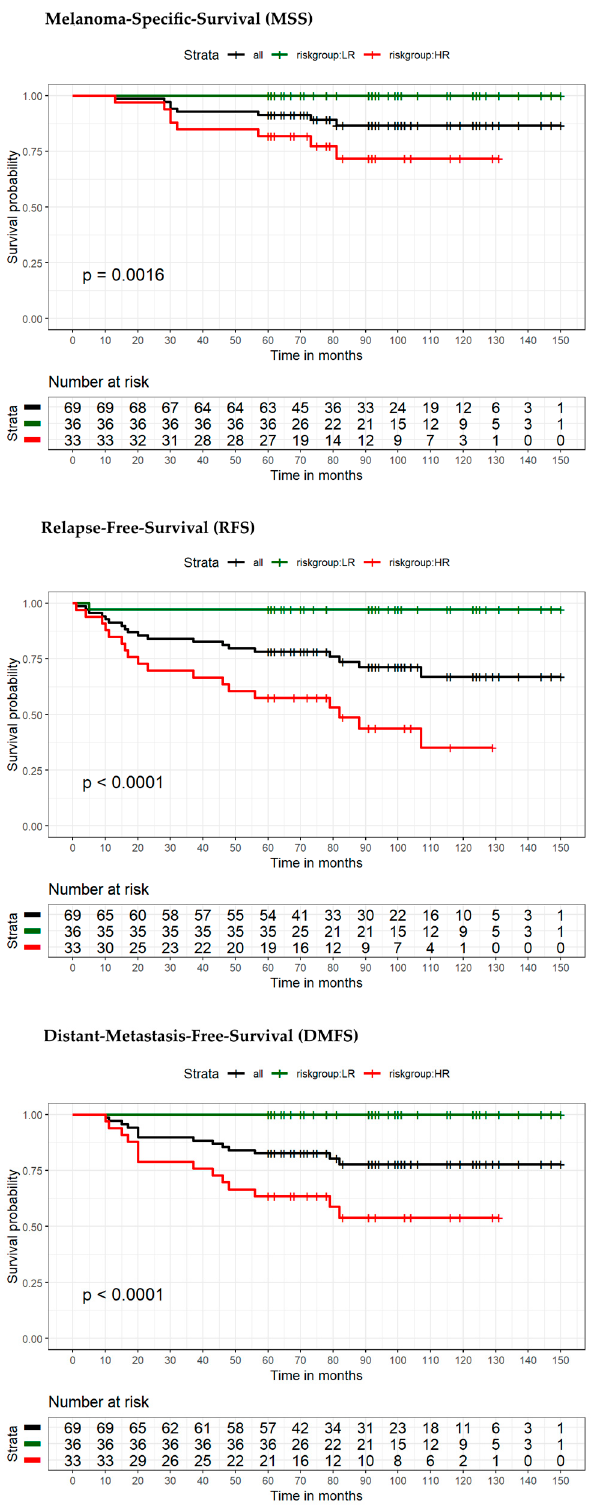
Figure 7. Kaplan–Meier survival estimates of patients with positive nodal status stratified into high- Figure 6. Kaplan–Meier survival estimates of patients with negative nodal status stratified into risk and low-risk by seven-marker signature. Endpoints were MSS, RFS, DMFS at 5- and 10-year high-risk and low-risk by the seven-marker signature. Endpoints were MSS, RFS, and DMFS at 5- follow-up. High-risk (in red), low-risk (in green) according to the seven-marker signature, and all and 10-year follow-up. High-risk (in red), low-risk (in green), and all patients (black). Corresponding patients (black). Corresponding tables with the number of patients at risk are given below. tables with the number of patients at risk are given